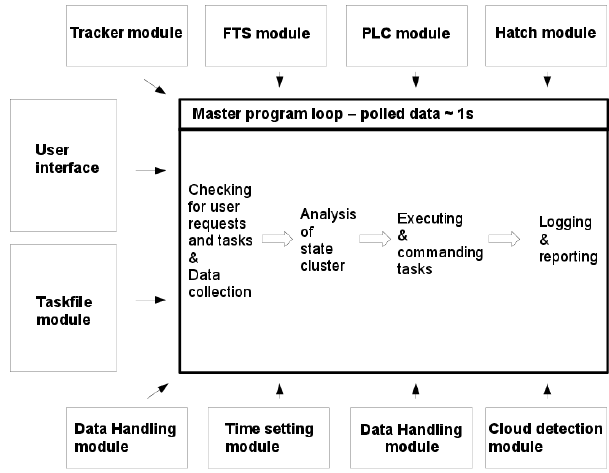
Fig. A2. Schematic of the interacting modules within the automa- tion software. The Master Program collects all information of the submodules, grouped around the Master program. The Master pro- gram itself is set up in a loop process. It checks for local or remote user requests, collects the provided information of the submodules and analyzes these information. By commanding tasks to the sub- systems, it executes subsequent actions. At the end of one loop, it logs all information as the state of the automation system.